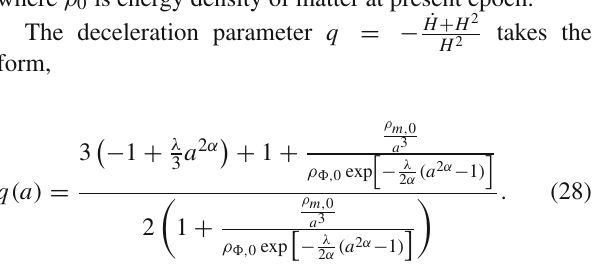
Fig. 4 ˙ S tot is plotted as a function of N . a in thawing scenario (for α = 0 . 3 , 0 . 5 and 0 . 9) b in freezing scenario (for α = − 0 . 3 , − 0 . 5 and − 0 .